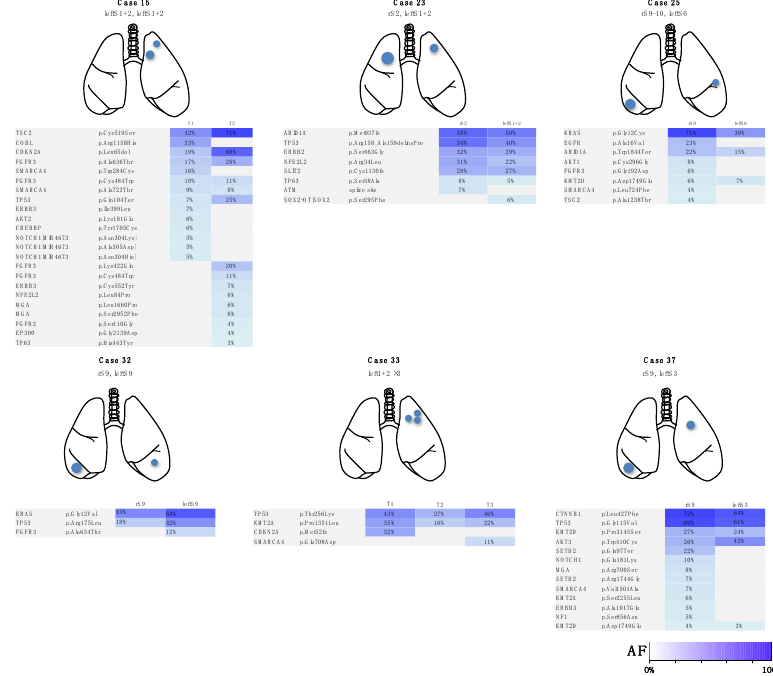
Figure 2. Heatmap of gene mutations in patients with metastatic lung cancers. The mutation profiles were consistent between the individual tumors in each case and the tumors were identified